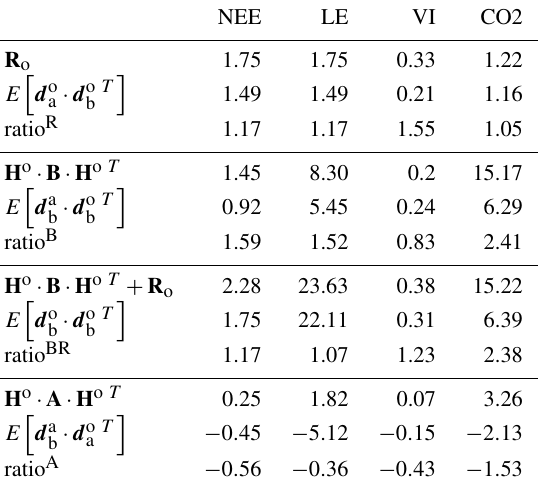
Table 3. Consistency diagnostics of the error covariance matrices for the F (using NEE and LE data), VI and CO2 assimilation exper- iments. The ratios are calculated with the mathematical expectation term as the